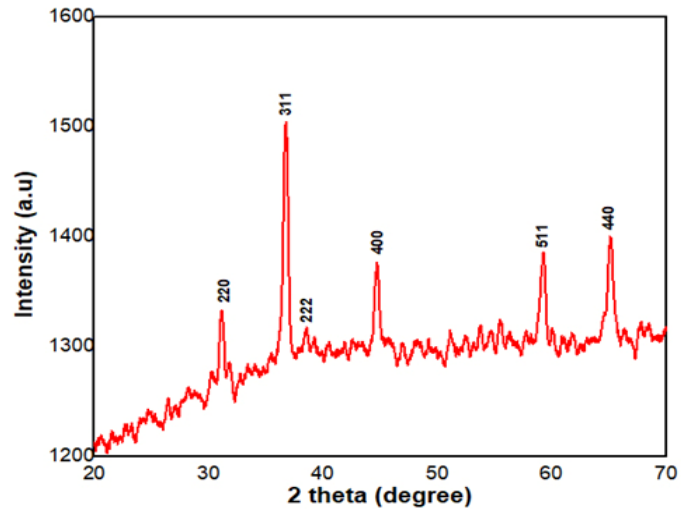
Figure 2. XRD analysis of Psidium guajava Co 3 O 4 NPs (JCPDS Card No. 073-1701).